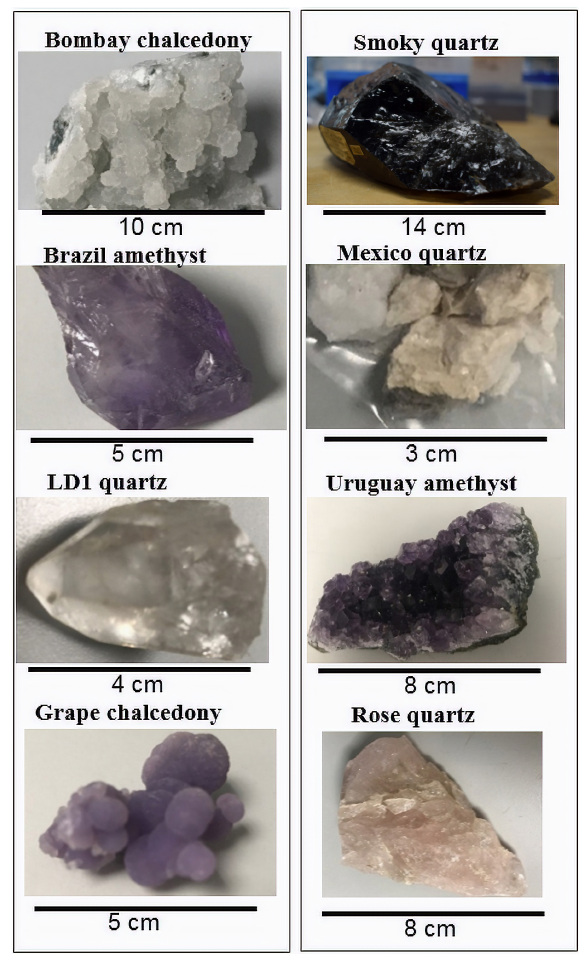
Figure 2. Pictures of the various quartz samples explored in this study showing their varying appearances and characteristics. Sam- ples supplied in a milled state are not